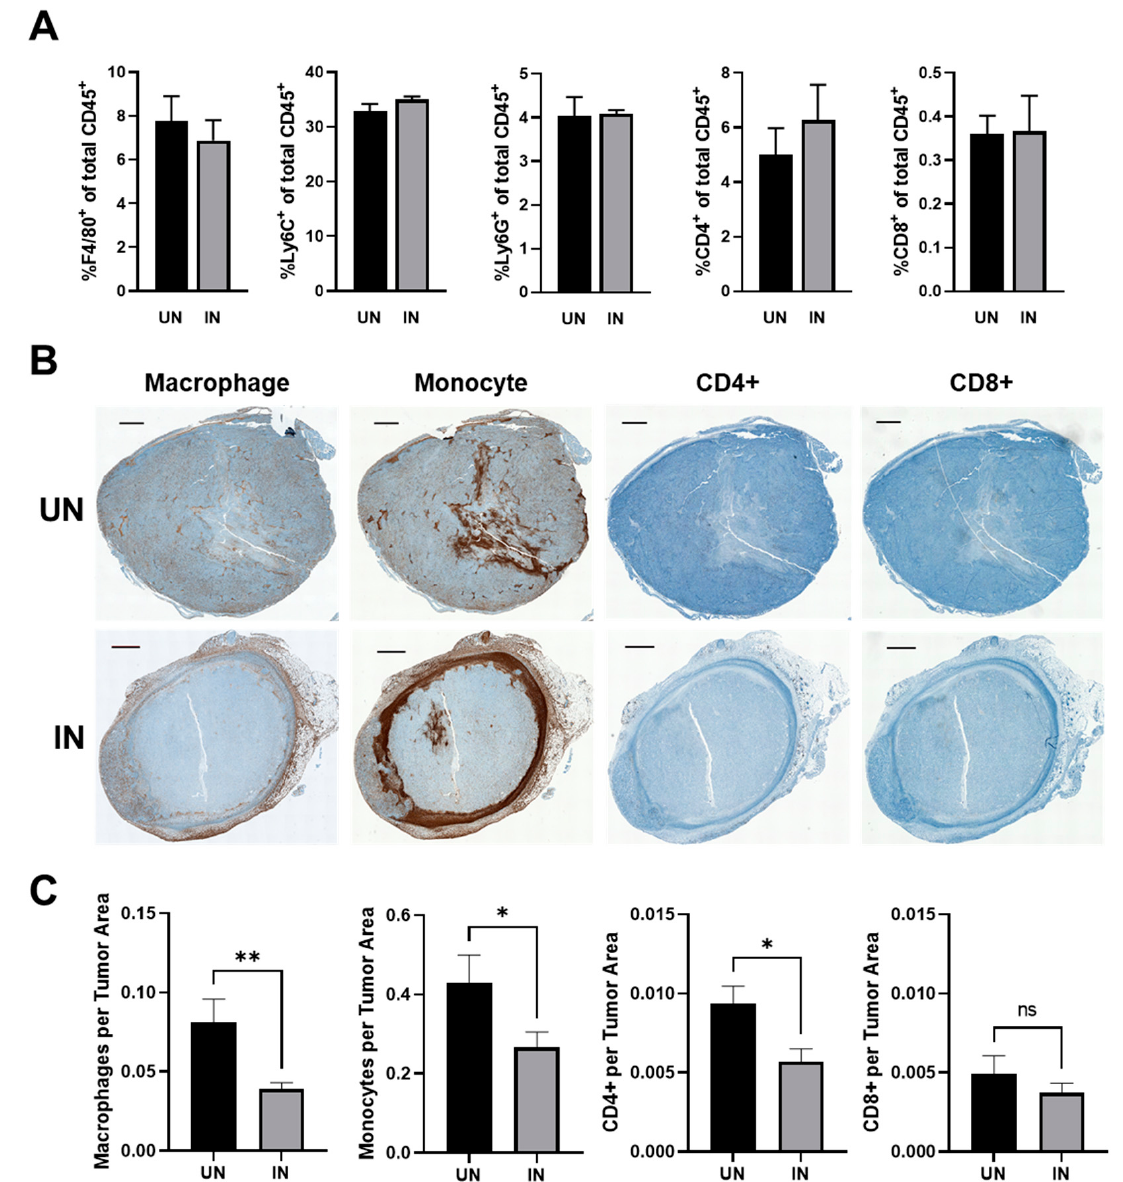
Figure 7. YS-HAse treatment restructures the BC immune contexture by reducing the prevalence of potentially suppressive subsets within the tumor center . ( A ) The flow cytometry analysis of YS- HAse-treated tumors. C57BL/6 mice bearing orthotopic EO771 tumors (~100 mm 3 ) were